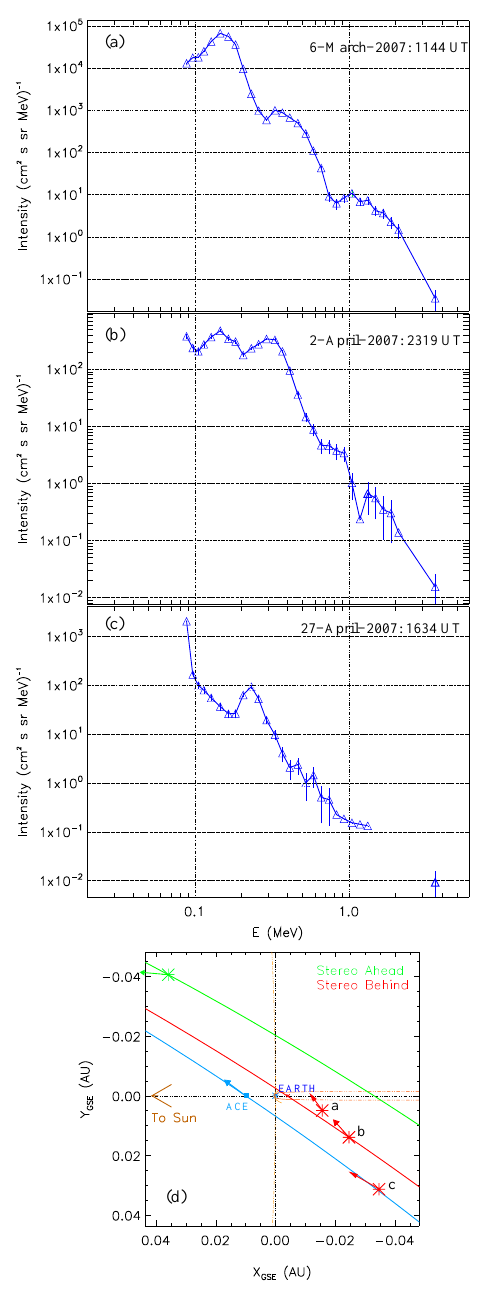
Fig. 3. AMI events observed at SEPT/STEREO-B far away from the magnetospheric tail: (a) three-peak spectrum on 6-March-2007; (b) two-peak spectrum on 2-April-2007; (c) one-peak spectrum on 27-April-2007, (d) position of STEREO-B during events a,b,c in relation to the Earth’s bow–shock and the magnetosphere (orange lines). The red arrows indicate the ecliptic IMF component during the events. The red, green and blue lines show the nominal Parker spiral for event (b) according to the solar wind speeds measured at both STEREO and at ACE spacecraft, respectively.